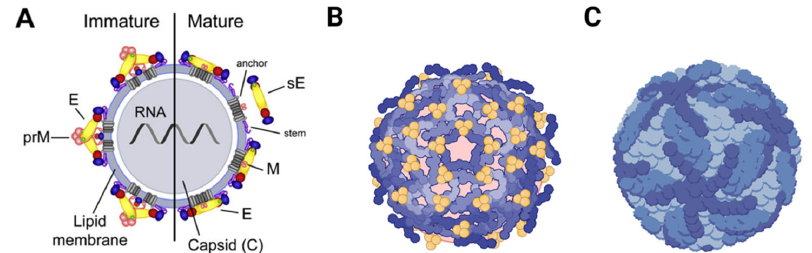
Figure 1. Representation of the mature and immature virion structure of flaviviruses. The surface proteins are arranged in an icosahedral-like symmetry. Mature virions contain two virus-encoded membrane proteins (M and E), while immature virions contain a membrane protein precursor (prM). ( A ) Schematic representation of a mature/immature flavivirus. ( B ) Arrangement representation of E dimers on the surface of an immature DENV virus. ( C ) Arrangement representation of E dimers on the surface of a mature DENV virus.